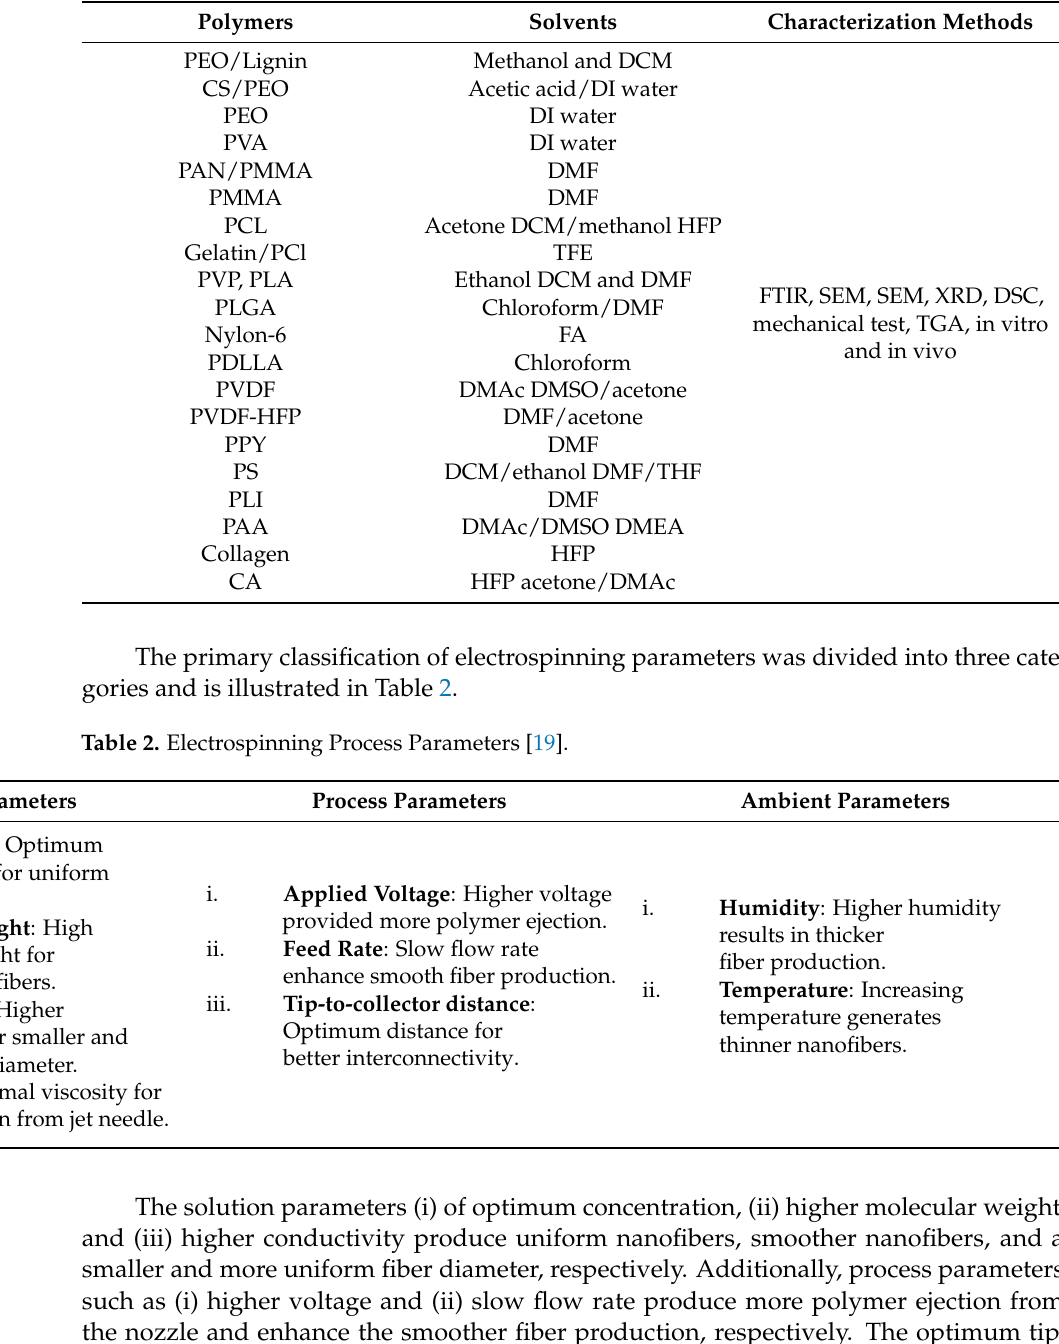
Table 1. Solutions and characterization methods of different polymers developed by electrospinning.